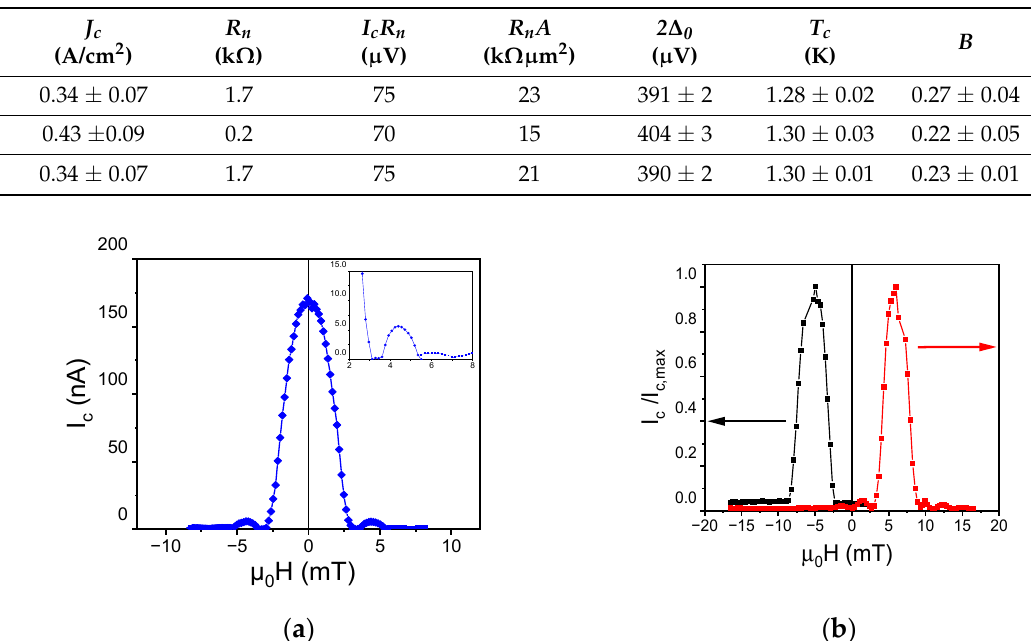
Table 1. Parameter of Al-based junctions at T = 10 mK, where D is the diameter of the junction, A is the area, J c is the critical current density, and R n is the normal resistance at T = 10 mK. The energy gap at T = 0 K, ∆ 0 , and the critical temperature T c are estimated as fitting parameters from the analysis of the V gap as a function of the temperature. B is a fitting parameter to consider the suppression of I C R N compared to the Ambegaokar-Baratoff expected value.